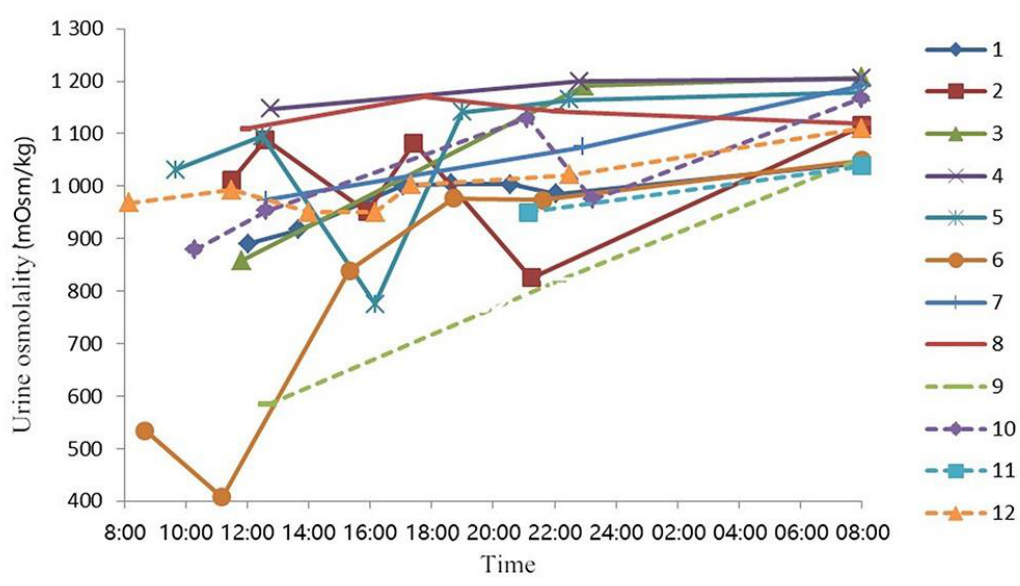
Figure 3. Changing trend of urine osmolality for each subject on day 3.